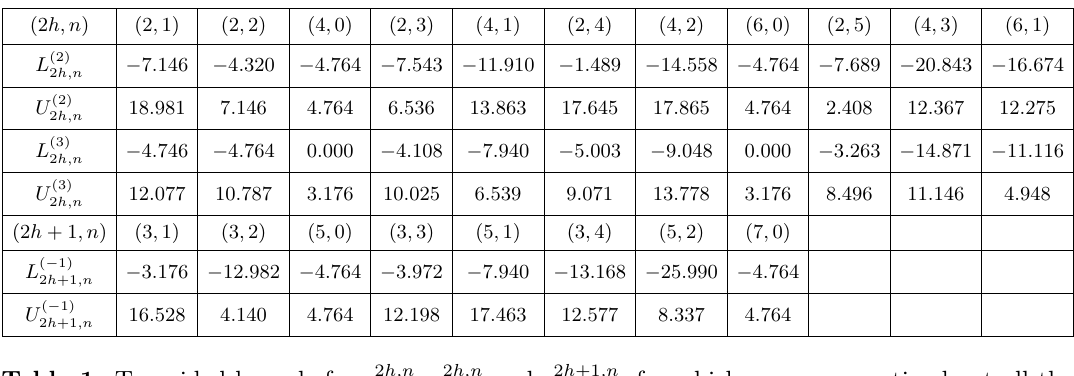
Table 1 . Two-sided bounds for c 2 h,n other coefficients except for the v 2 coefficients. L ( a ) units where the cutoff Λ = 1